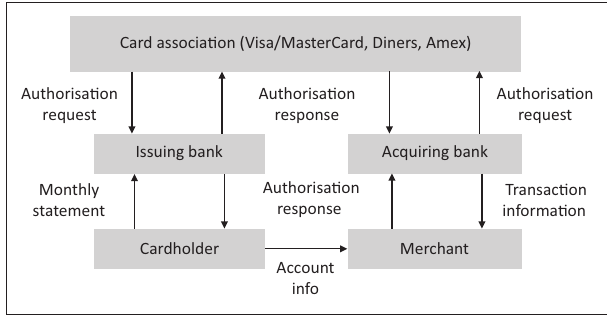
FIGURE 1: Multi-card issuer